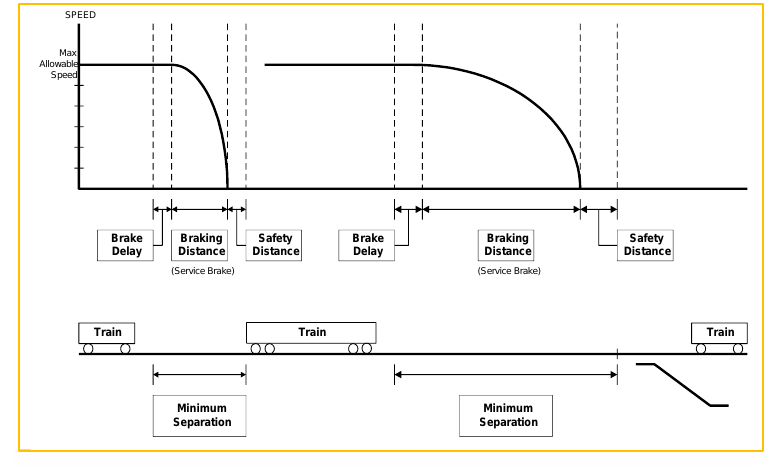
Fig. 2. Typical safe braking